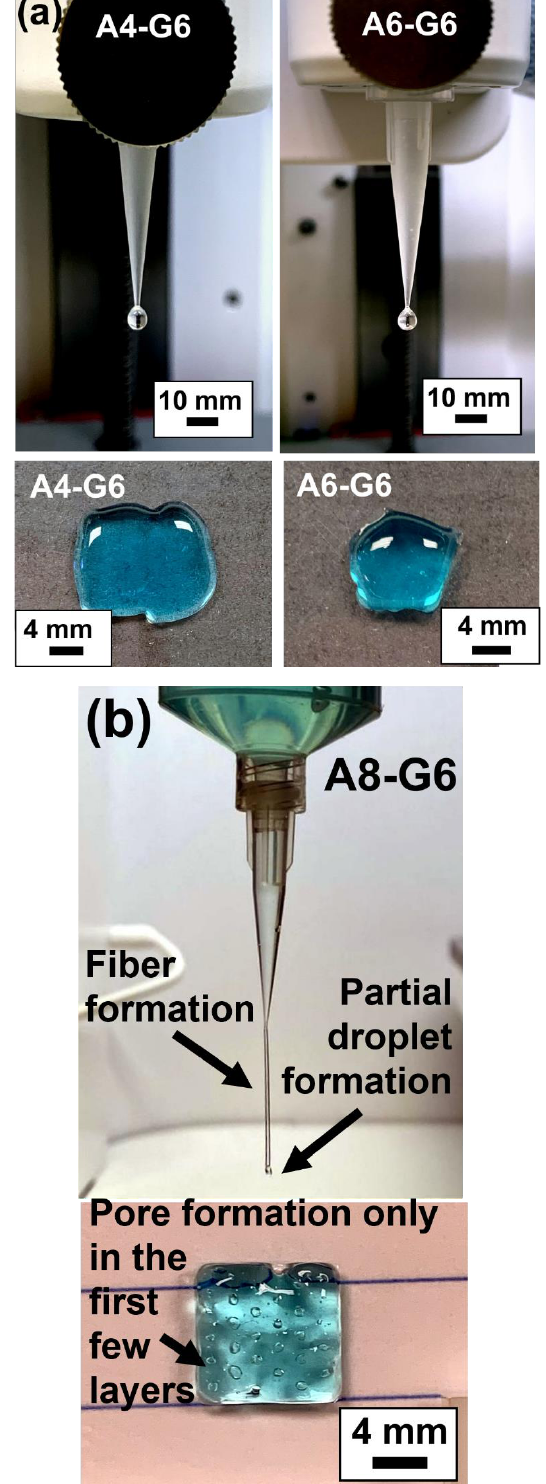
Figure 1. Manual dispensing results of the inks and the corresponding scaffolds printed with the same composition. ( a ) A4-G6 and A6-G6 inks predominantly formed droplets when extruded out of the nozzle. The printed scaffolds exhibited no structural and shape fidelity. ( b ) A8-G6 inks formed partial fiber formation and droplets. The scaffolds exhibited satisfactory shape and structural fidelity. However, pores were only formed in the first few